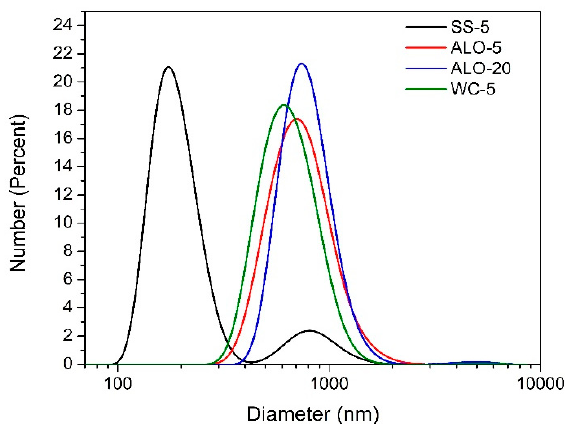
Figure 1. Particle diameter distributions of the ground samples in di ff erent vials determined by the dynamic light scattering (DLS) method.